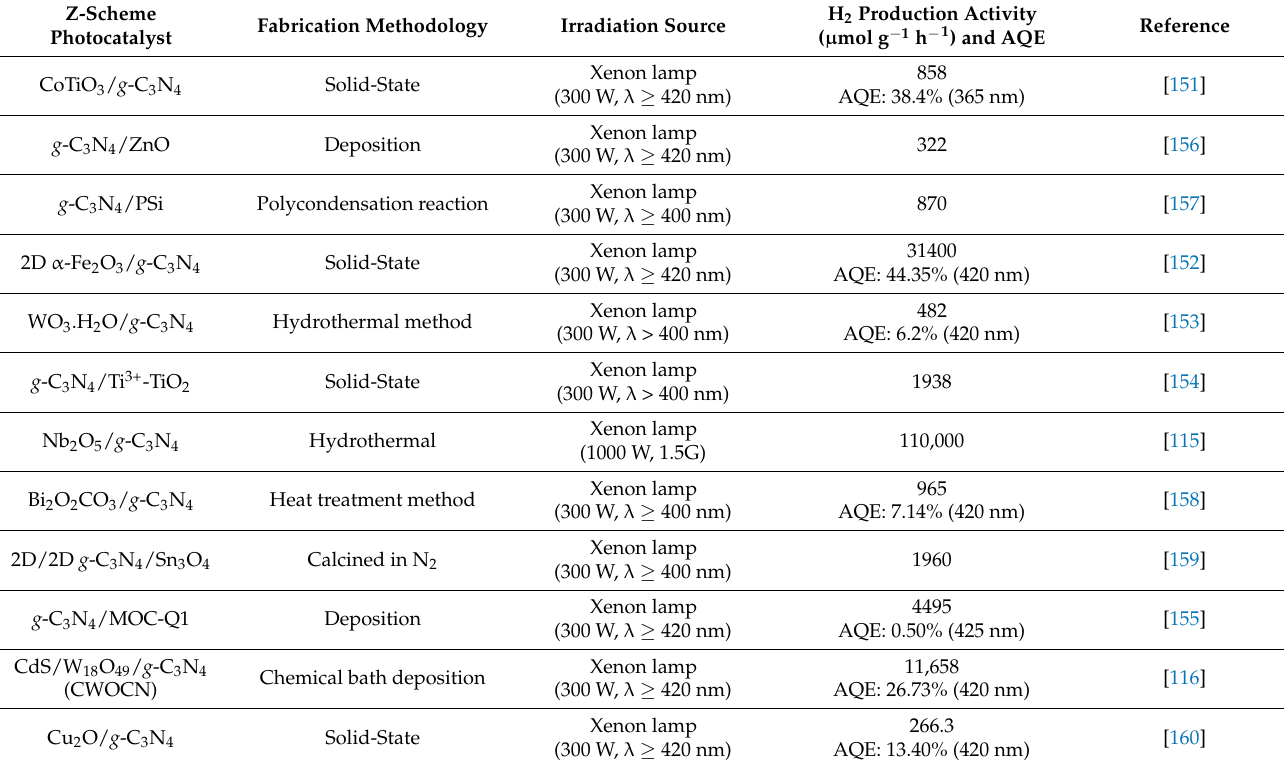
Table 2. Summary of direct Z-scheme photocatalysts based on g -C 3 N 4 for water